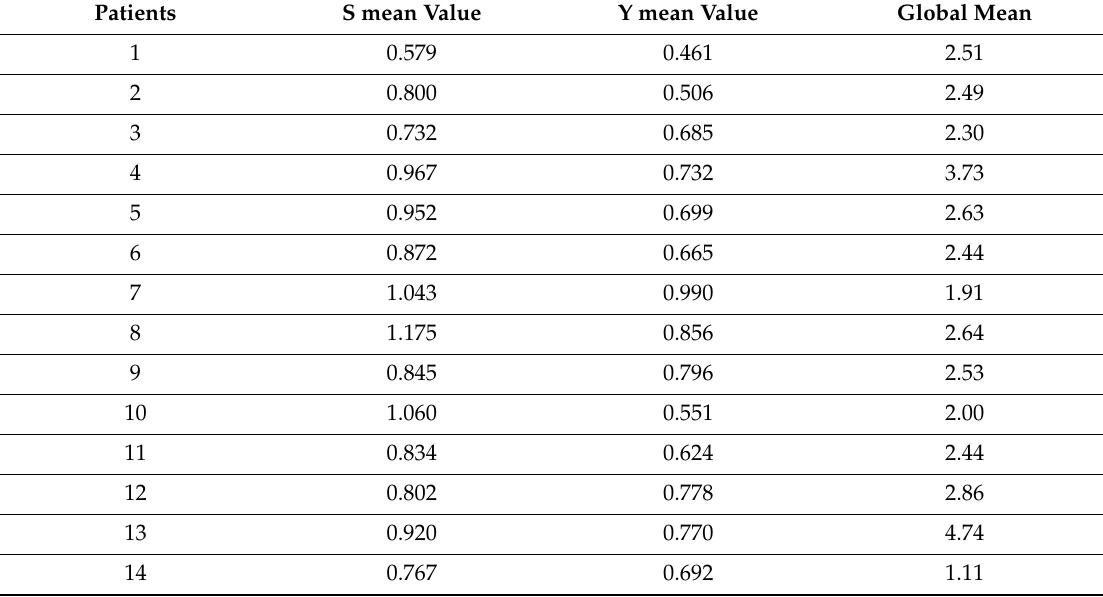
Table 3. Statistical 3D evaluation of discrepancies between the clinical and virtual implant positions in single patients using multivariate permutation tests.